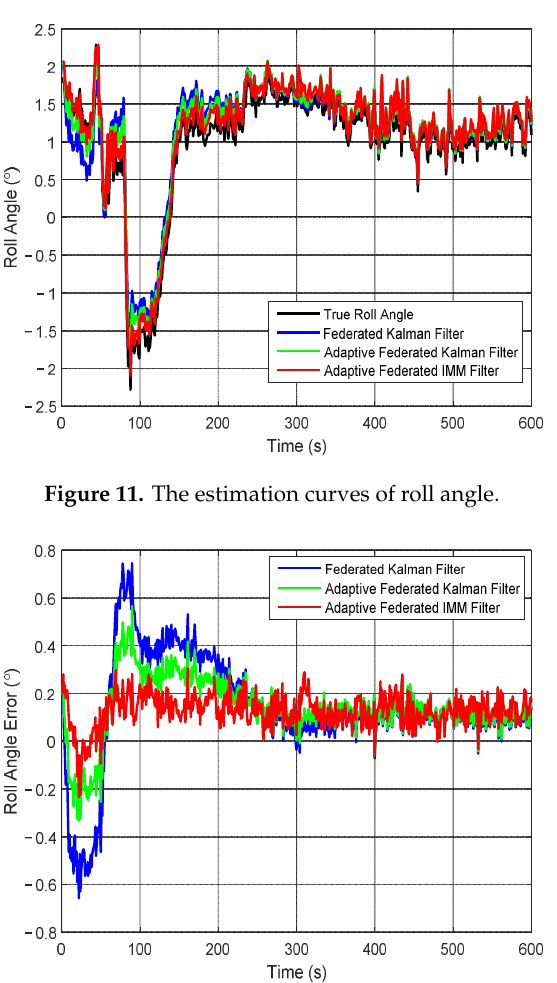
Figure 13. The estimation curves of east velocity.